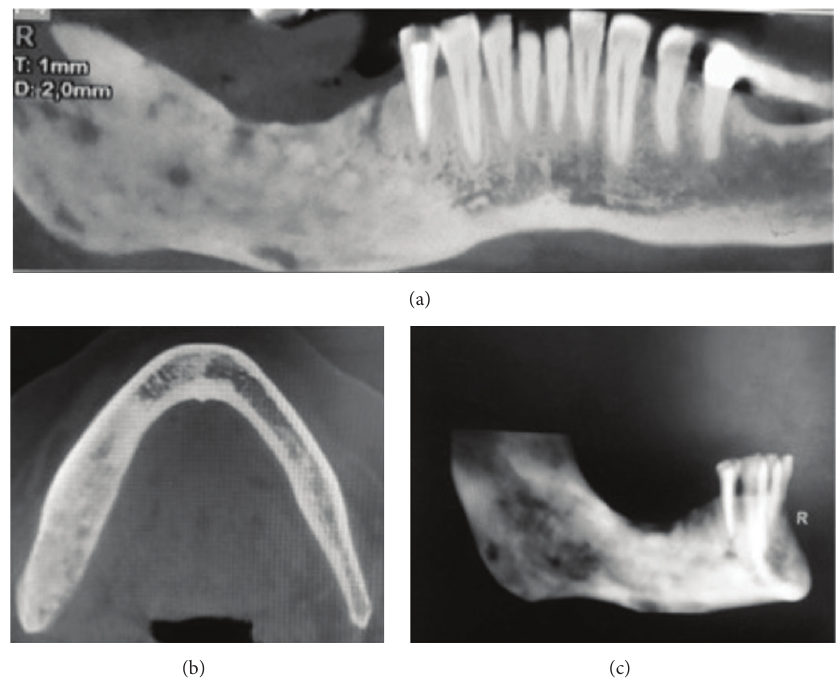
Figure 6: CT scan performed on April, 2015. (a) Panorex view showing sequestrum, (b) axial view, and (c) 3D